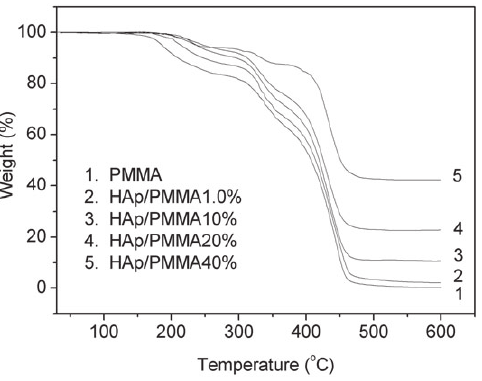
Figure 7 TGA curves of HAp/PMMA nanocomposites and